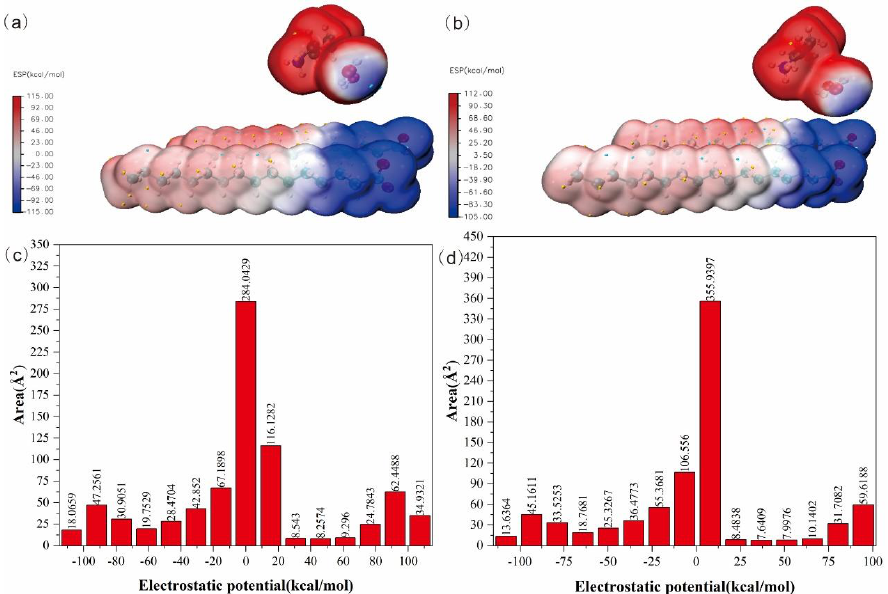
Figure 14. Molecular surface electrostatic potential diagrams and molecular surface electrostatic potential quantitative distribution diagrams of the title compounds: ( a ) molecular surface electrostatic potential diagram of 3C16; ( b ) molecular surface electrostatic potential diagram of 3C17; ( c ) molecular surface electrostatic potential quantitative distribution diagram of 3C16; ( d ) molecular surface electrostatic potential quantitative distribution diagram of 3C17.